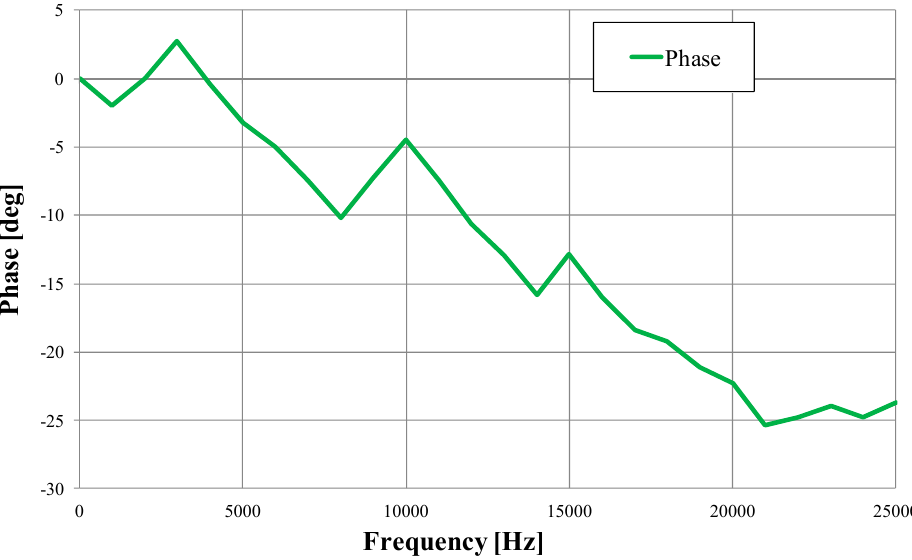
Figure 7. “Unwrapped” phase in cross-spectrum method. An example of test results from pure RCA specimen No. 2, T = 0.16 ms, p ′ = 90 kPa.